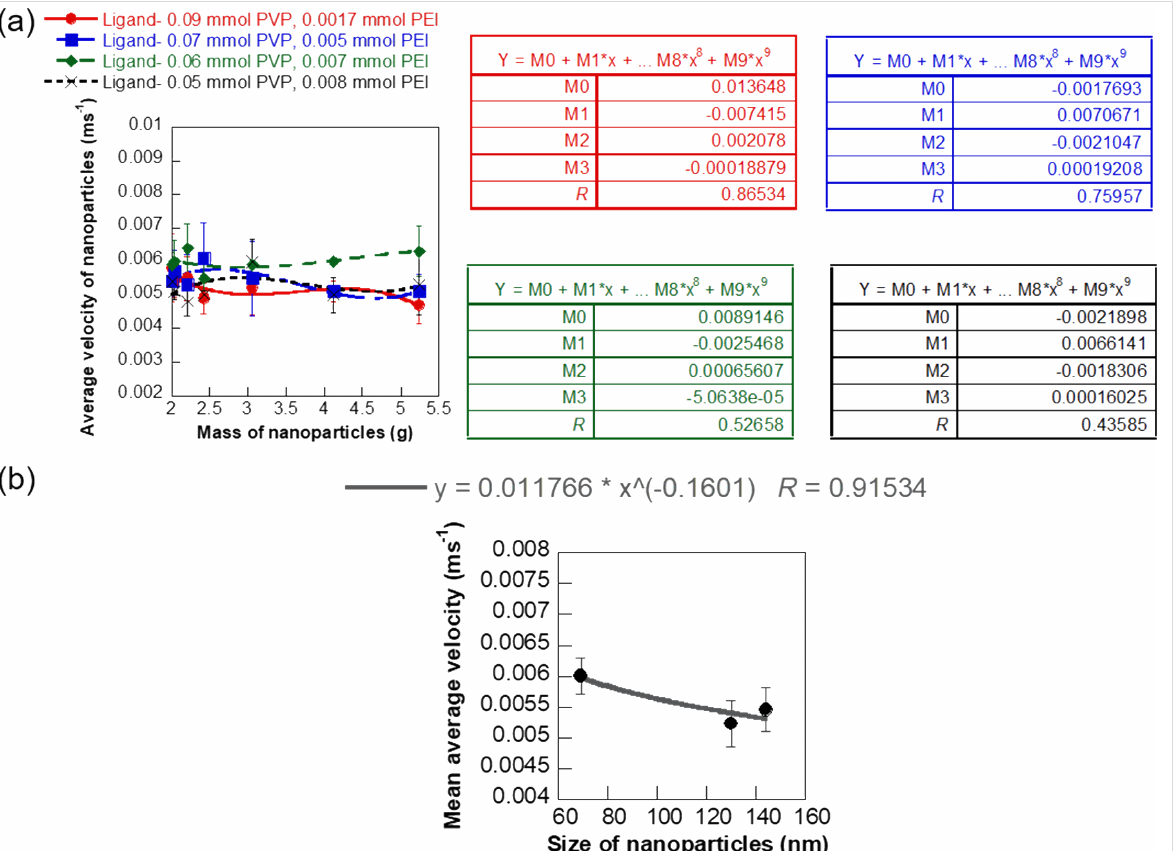
Figure 7: Experimental velocity profile of the iron oxide NPs. (a) Plot showing the average flow velocity of the different iron oxide NPs at different inlet mass concentrations and (b) variation of the average NP velocity with size of the NPs. The error bars represent standard